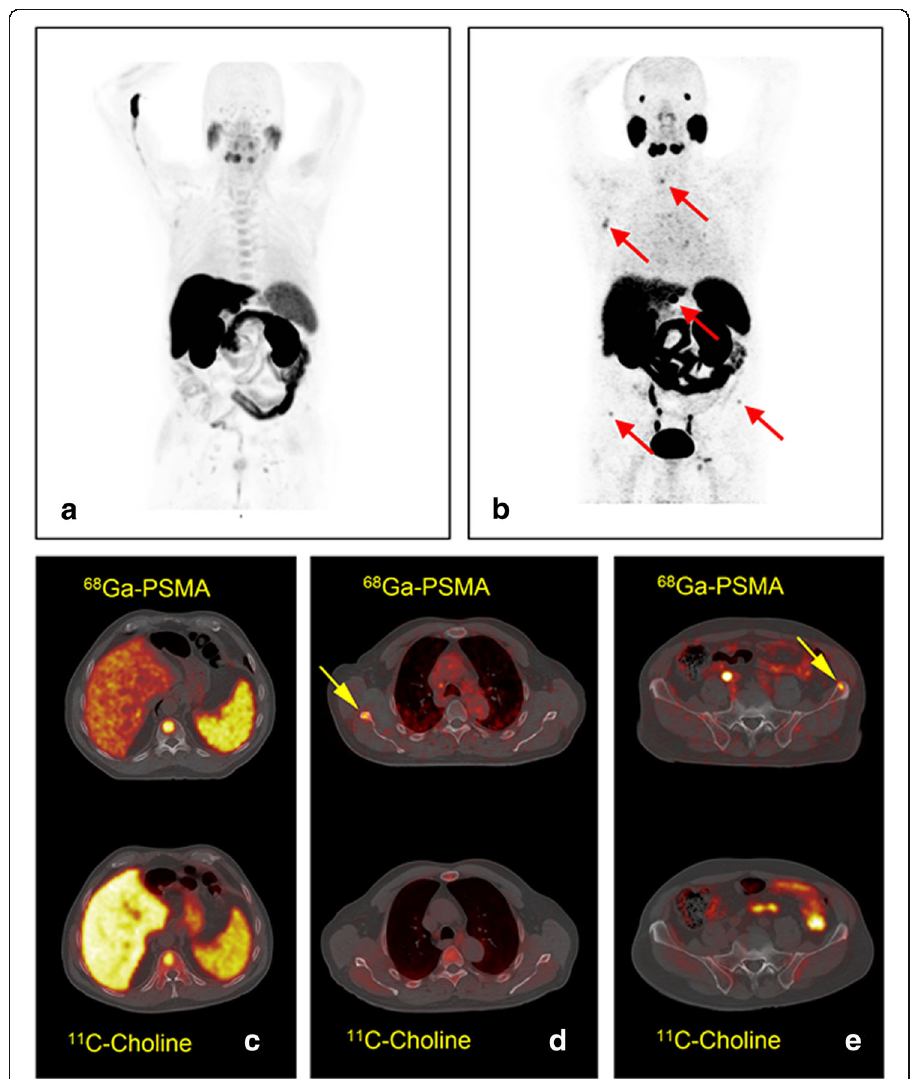
Fig. 1 Patient 1. A 67-year-old patient treated with radiotherapy and hormonotherapy with PSA relapse (PSA level 8.7 ng/ml). MIP images with bone metastases (red arrows), scanned with 11 C-Choline ( a ) and with 68 Ga-PSMA ( b ). Metastasis in T11 demonstrated with both tracers ( c ). Right scapula ( d ) and left iliac crest ( e ) focal lesions demonstrated only with 68 Ga-PSMA (yellow